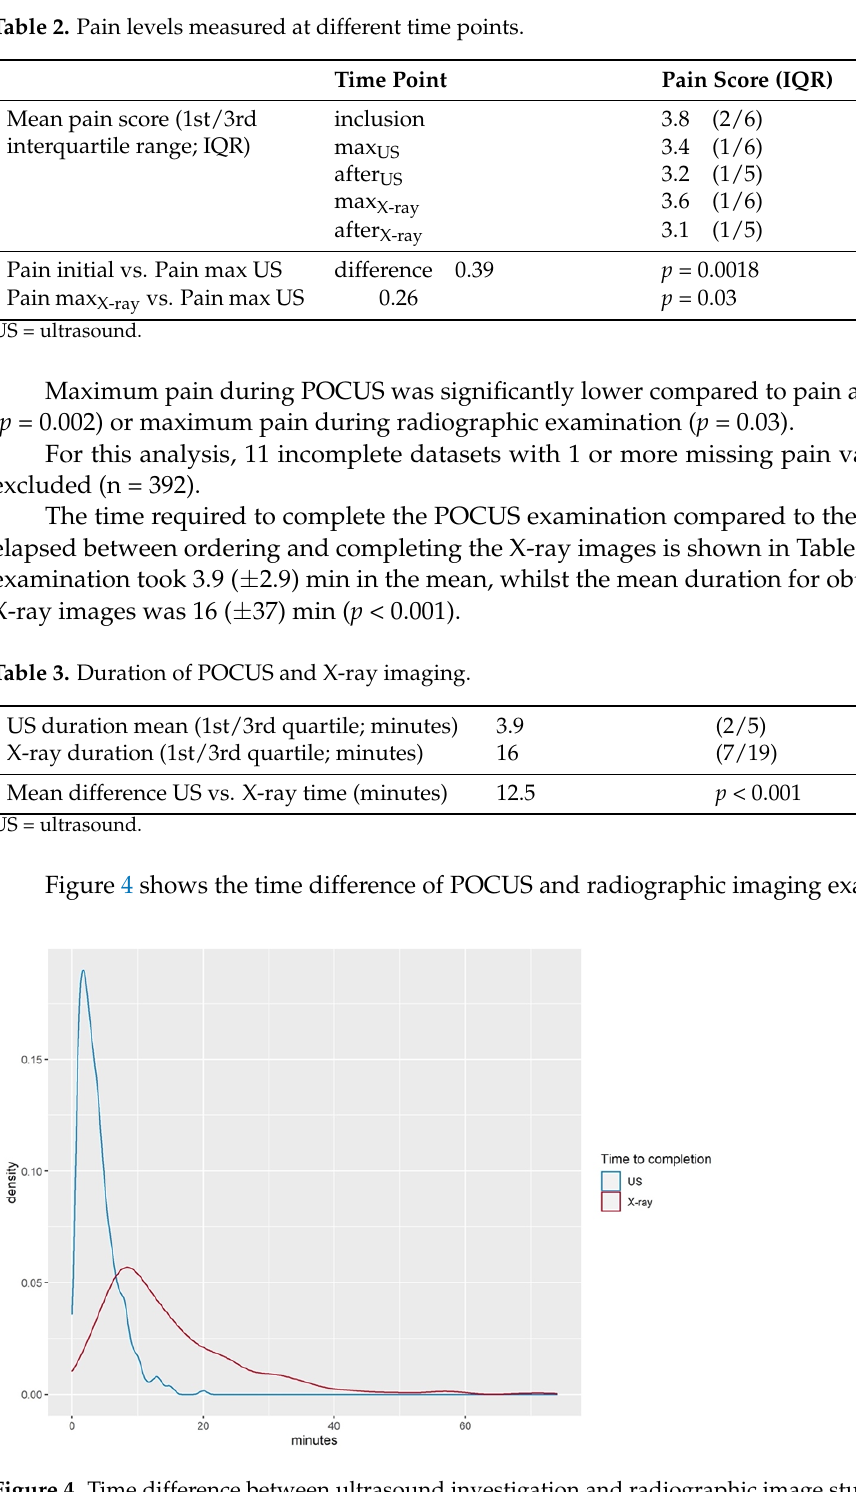
Figure 5. Learning progression. Red: positive fracture sign in POCUS and X-ray without subjective need for an X-ray; green: exclusion of fracture in POCUS and X-ray without subjective need for an X-ray; yellow: results with subjective need for an X-ray.